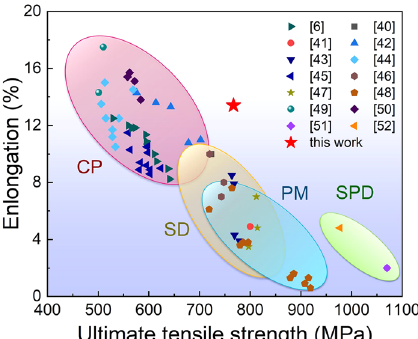
Fig. 9 Comparison of ultimate tensile strength and elongation of high-strength aluminum alloy 6,38 – 50 . CP is the conventional industrial production process, SD is the spray deposition process, PM is the powder metallurgy process, and SPD is the severe plastic deformation process.